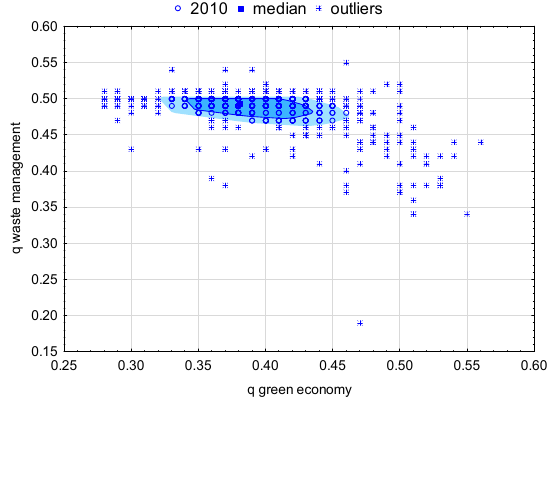
Figure 6. Spread of the synthetic measure, waste management and green economy in communes of Eastern Poland in 2010–2020. Source: own study. In the case of the relationship between the synthetic measure, green economy, and waste management, as shown in Figure 7, we observe negative values ( − 0.494; − 0.468; − 0.461; − 0.459; an increase in the value of one variable followed by a decrease in the value of the other). The bag chart shows groups of statistically similar municipalities (including outliers, whose graphic shape in subsequent years indicates their differentiation).